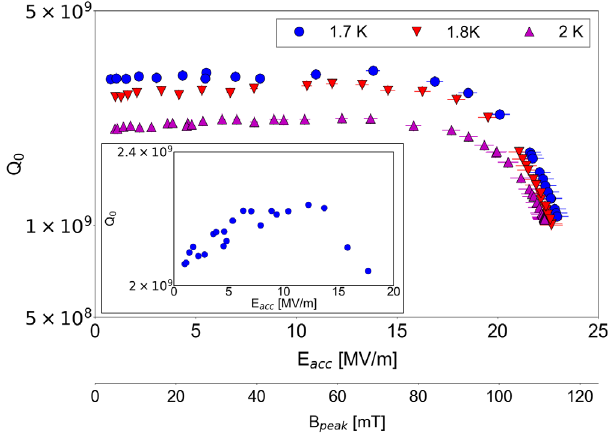
FIG. 3. Power rises for cavity 3HZ015. In the box, the Q vs E curve at 2 K is magnified in the 0 – 20 MV = m zone so to point out a slight medium field anti-Q slope.